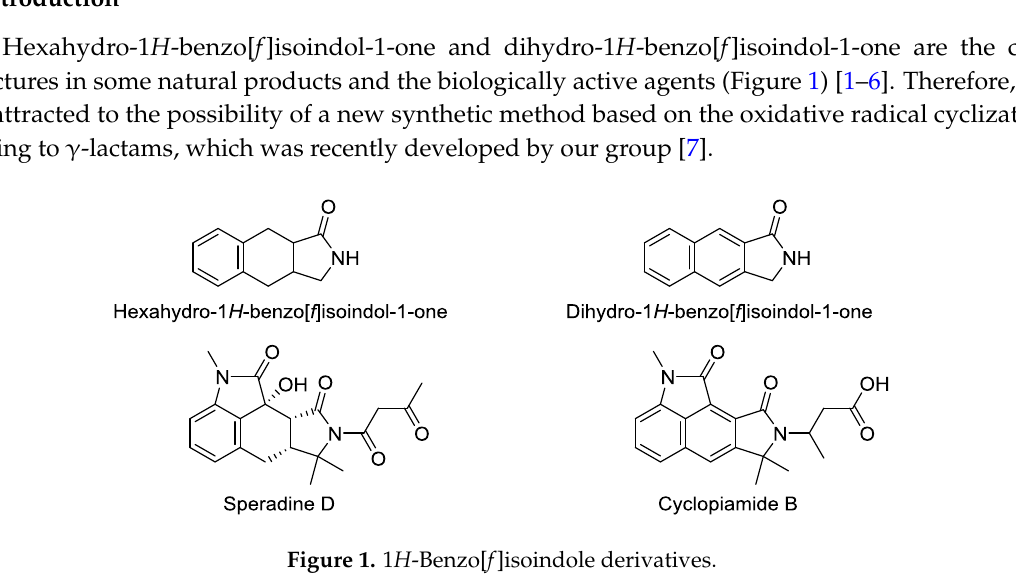
Figure 1. 1 H -Benzo[ f ]isoindole derivatives.